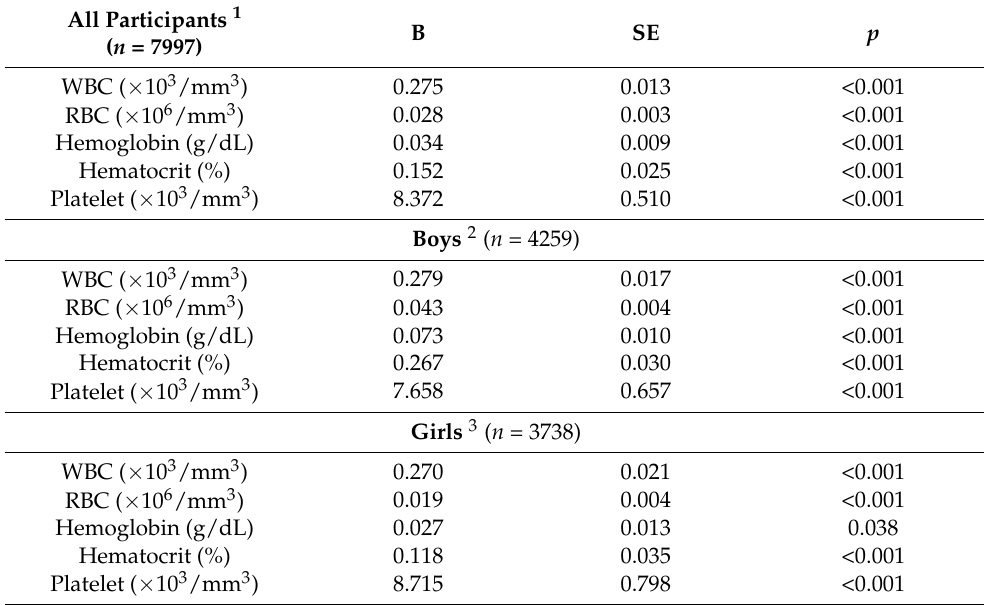
Table 5. Multiple regression analysis of the associations of body mass index (BMI) standard devi- ation score (SDS) with white blood cell (WBC), red blood cell (RBC), hemoglobin, hematocrit, and platelet